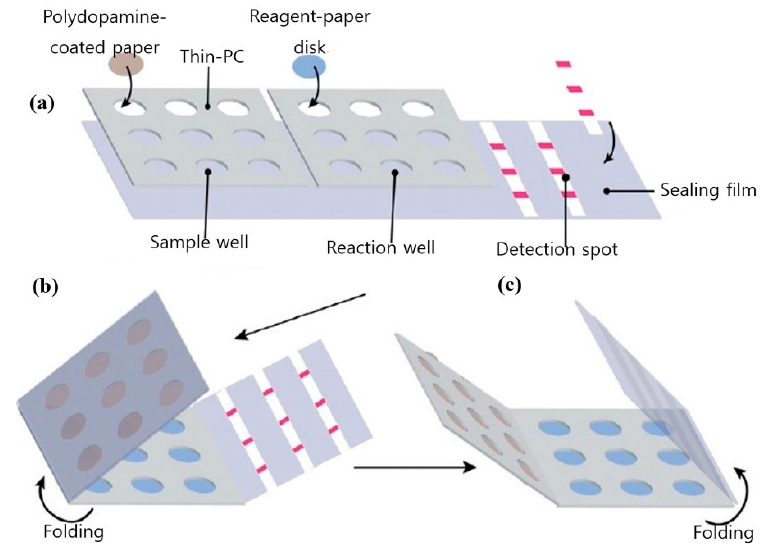
Figure 2. Design and fabrication of the foldable microdevice. ( a ) The microdevice’s three main components include a sample zone with nine sample chambers, a reaction zone with nine reaction chambers and a detection zone with three paper strips; ( b ) folding step for extraction; and ( c ) folding step for detection. Figure modified with permission from [40]. (Copyright 2019, Royal Society of Chemistry).